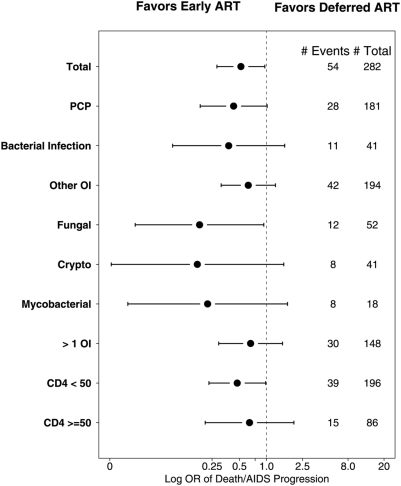
AIDS Progression/Death by entry diagnoses given as log Odds ratios (with 95%CI) with OR <1.0 favoring early versus deferred ART.Total, fungal and CD4<50 categories represent significance at p<0.05. (Fungal Infections include cryptococcal infections and histoplasmosis).